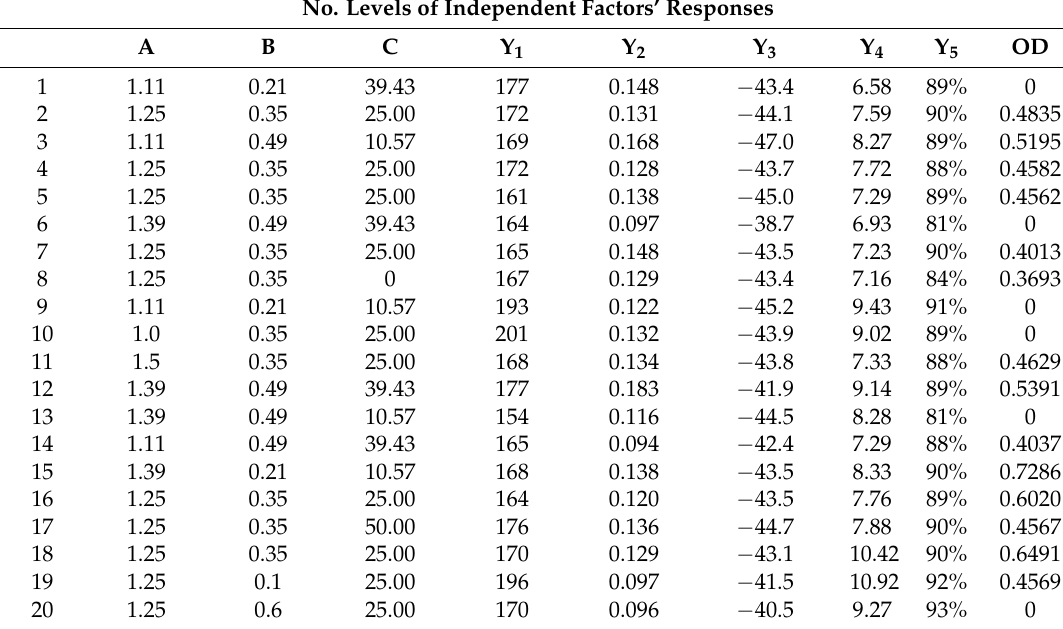
Variables and observed responses in the central composite design for imperatorin lipid microspheres.